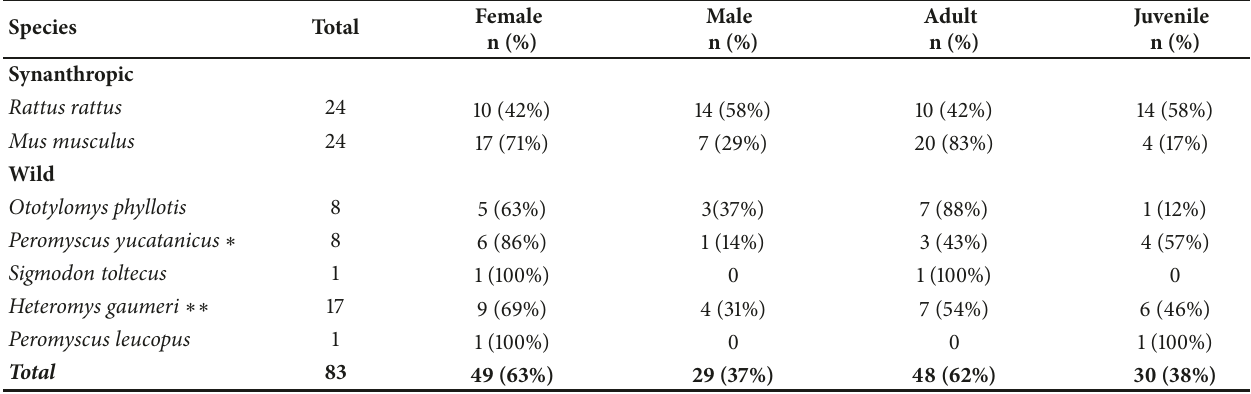
Table 1: Total number of rodents and frequency (%) of sex (female/male) and age (adult/juvenile) of synanthropic and wild rodents captured in a rural community of southwest